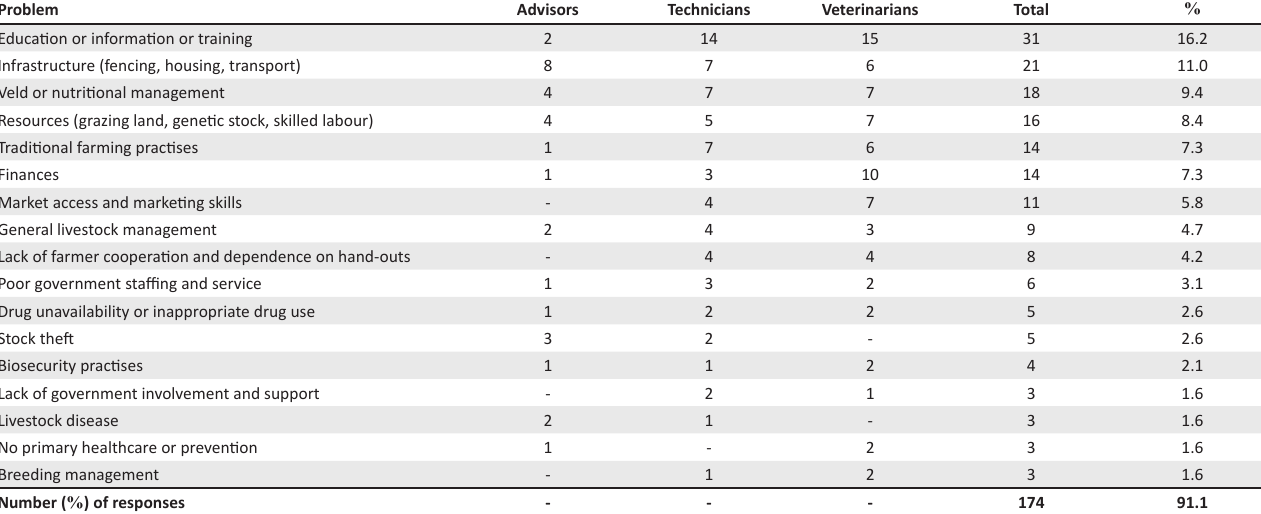
TABLE 3: Production advisors, animal health technicians,